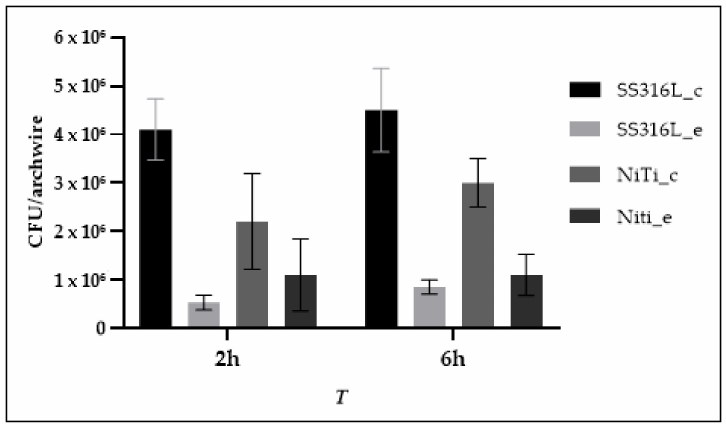
Figure 4. S. mutans adhesion to control and experimental surfaces at 2 and 6